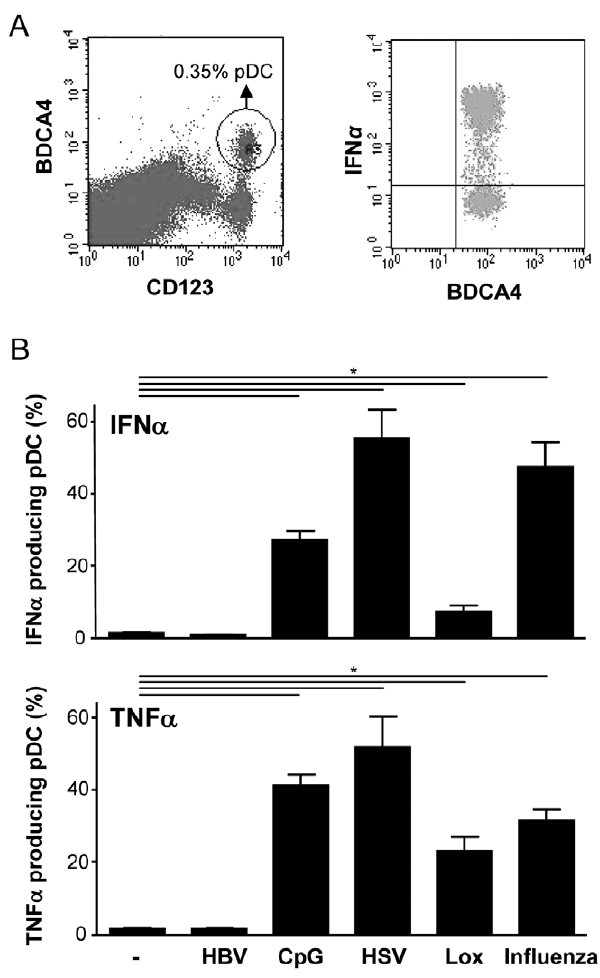
Figure 1. HBV does not activate pDC. A : PBMC were stimulated with CpG and analysed for IFN a production by pDC as described in Materials and Methods . Shown is a representative FACS plot of PBMC stained for CD123 and BDCA-4 to identify pDC and the detection of IFN a positive cells within this pDC-gate. B : IFN a and TNF a producing pDC within PBMC cultured in the presence or absence of HepG2.215- derived HBV, CpG, HSV-1, Lox or Influenza are presented as mean 6 SEM of 10 independent